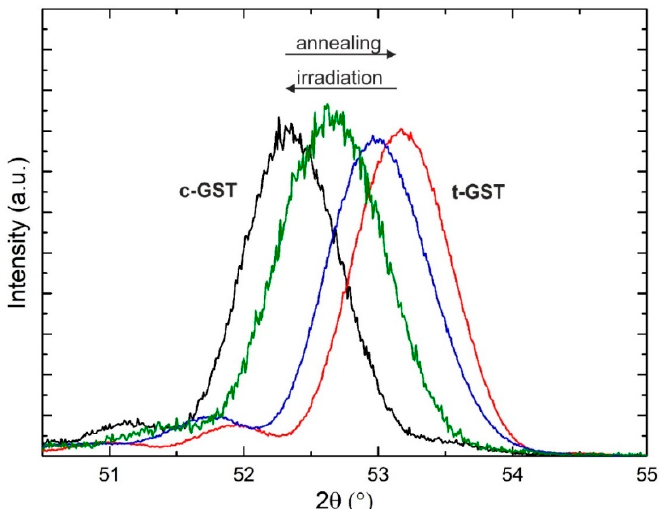
Figure 8. XRD pattern of the c-GST (222) and t-GST (00010) reflections of an epitaxial GST thin film after different steps of thermal treatment involving ns-laser irradiation as well as thermal annealing. The thickness of the GST thin film was approximately 15 nm (estimated from the Scherrer equation).